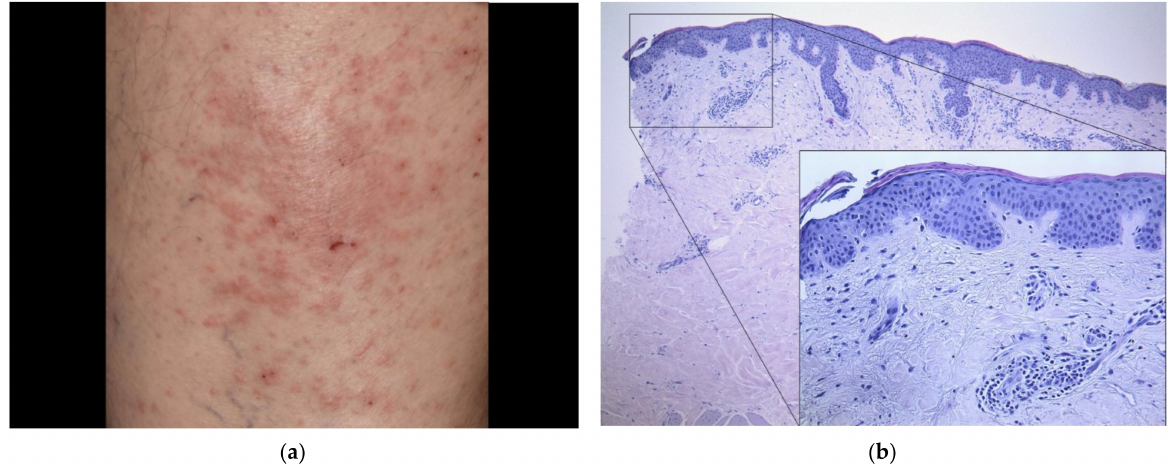
Figure 4. ( a ) Clinical findings four weeks after the second dose of BNT162b2 resembling an eczematous reaction distant from the injection site on the dorsal upper thigh. ( b ) Histological findings of a skin biopsy taken from the trunk of the patient 14 days after the second dose of the vaccine showing parakeratosis and slight dermal edema with neutrophils and eosinophils (HE, original magnification 50 × , detail original magnification 200 ×